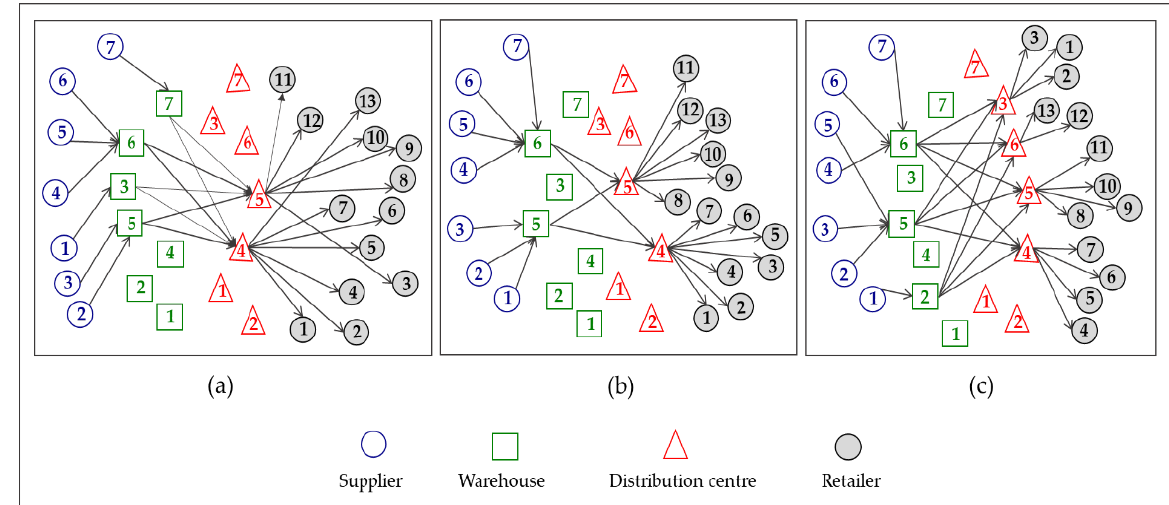
Figure 3. Optimal network configurations of the scenario S_eco: ( a ) distribution network in the demand uncertainty case;